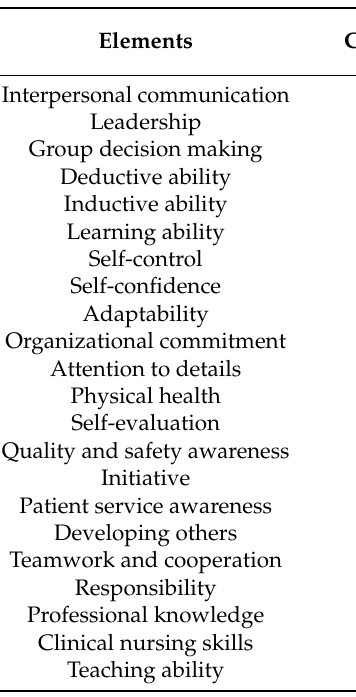
Table 4. Reliability test of competency elements.